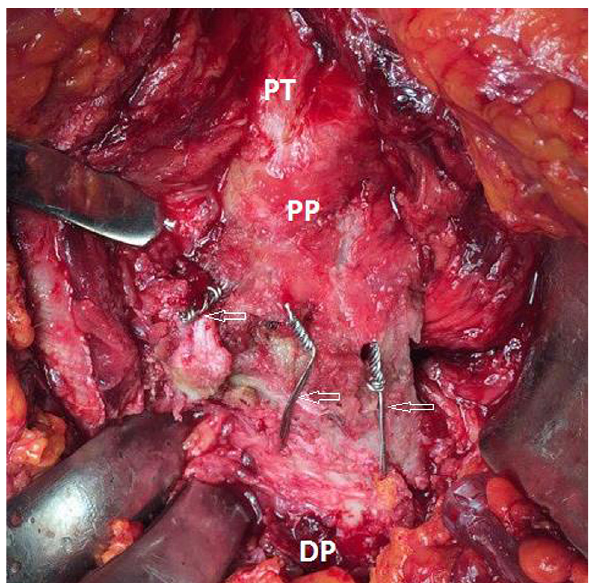
Figure 2. Anatomical positioning and fixation of the lesser